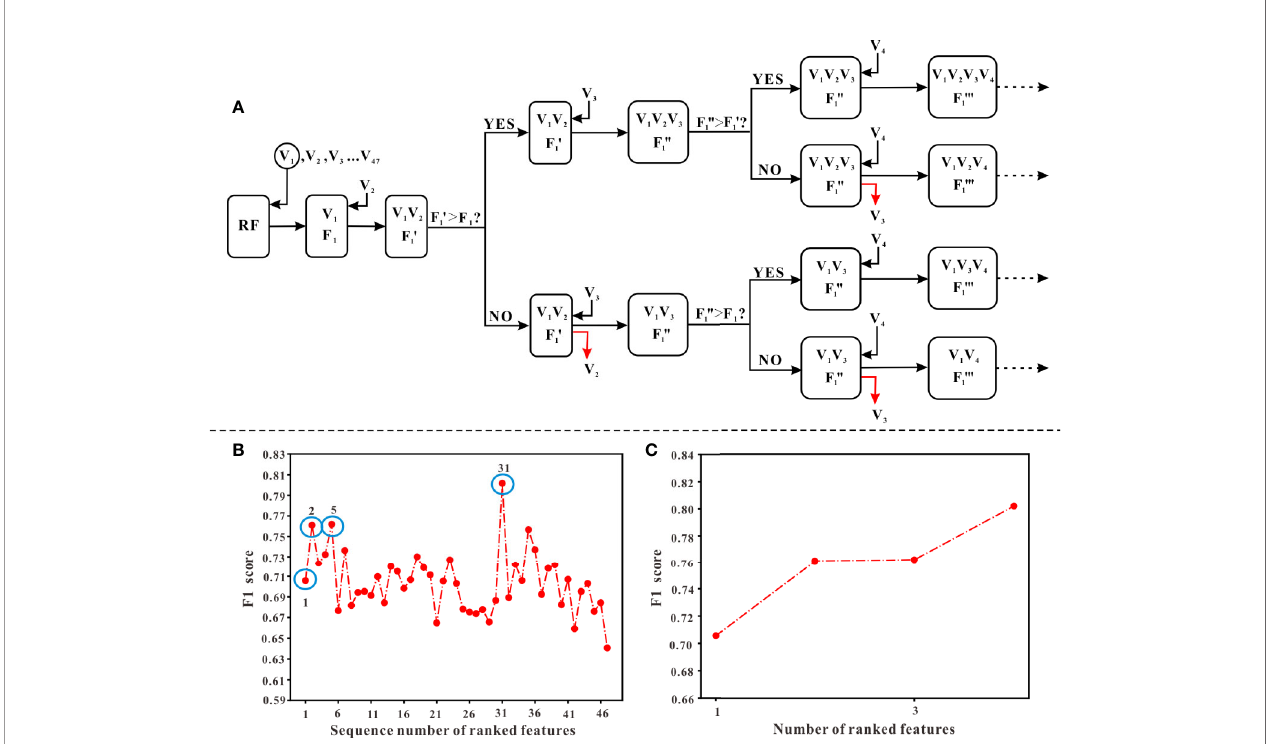
FIGURE 3 | The procedure of feature selection. (A) The fl owchart of selecting features. Ranked variables according to their information gain values (from high to low, see ). Starting from V 1 (the fi rst variable) which has the highest information gain values, variables were input into the model generated by RF algorithm in order. A corresponding “ F 1 ” score, calculated when adding a new variable, should be compared with the previous “ F 1 ” score. Only when the “ F 1 ” score was higher than the previous “ F 1 ” score, the new variable could remain in the model and continued to input the next variable. Otherwise, it should be abandoned and continued to input the next variable. (B) The overall variation curve of F 1 scores of 47 variables. Variables of sequences 1, 2, 5, 31 marked with blue circles were the variables fi nally selected, including TJC, Time interval, LYM, and Weight. (C) The variation curve of F 1 scores of TJC, Time interval, LYM, and Weight.